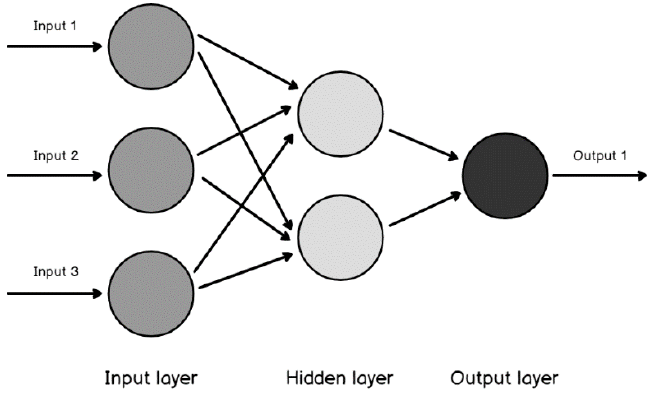
Figure 3. Diagrammatic representation of ANN.